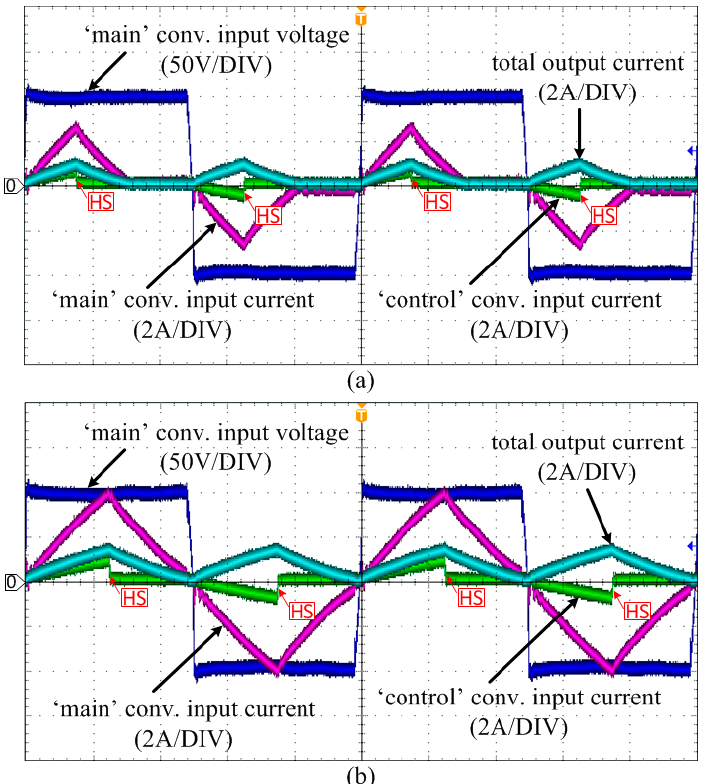
Figure 13. Voltage and current waveforms in the transformers when the BiDUP converter operates in the forward mode with the ‘control’ converter duty-ratios of ( a ) 0.15 and ( b ) 0.25, respectively.